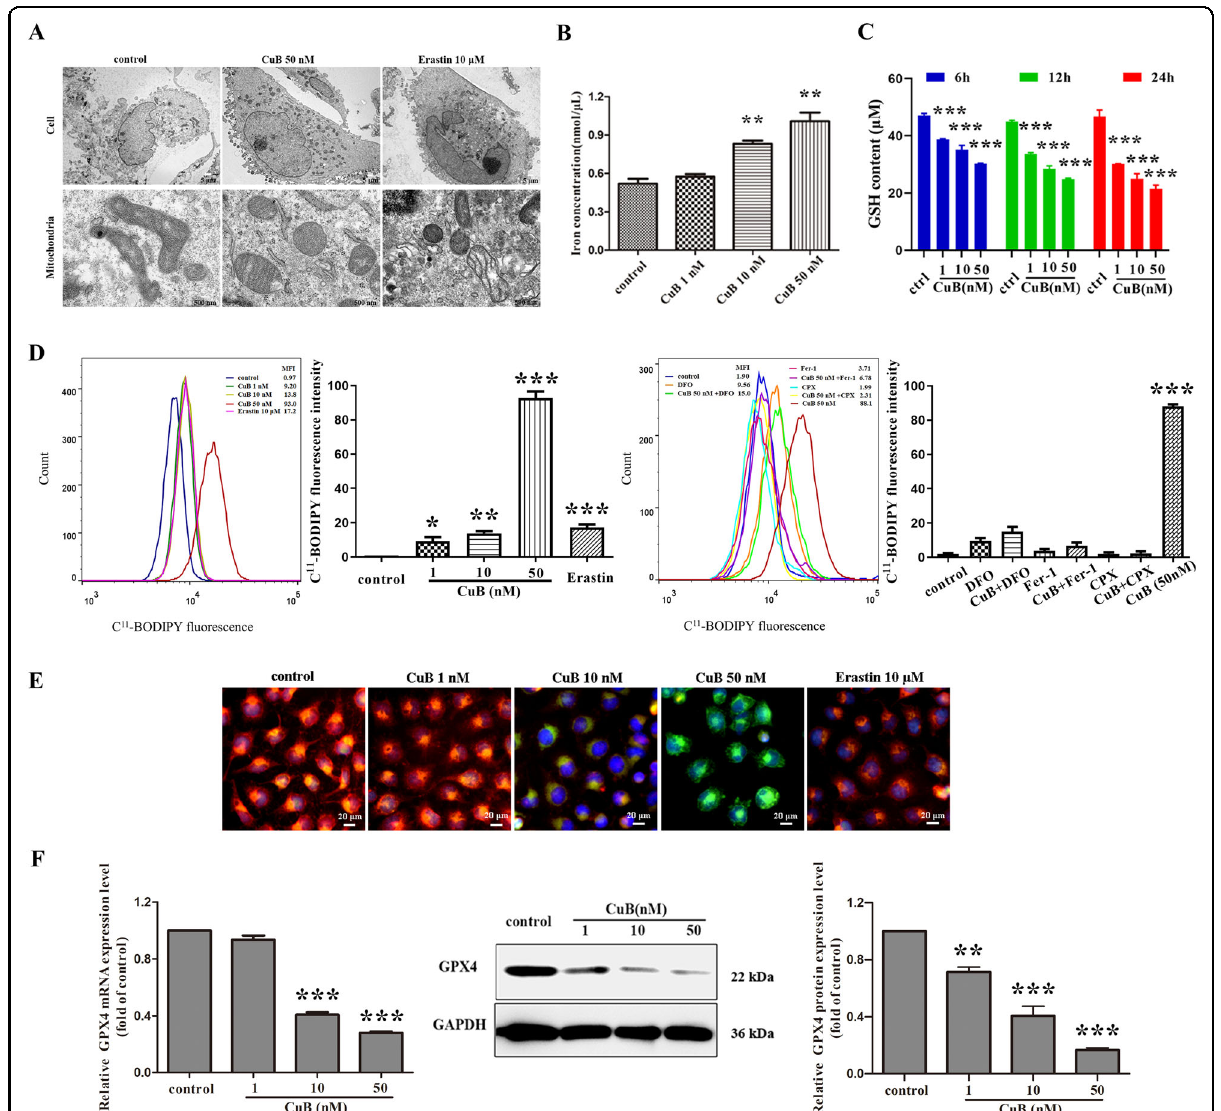
Fig. 4 CuB induced ferroptosis. A Representative cell and mitochondrial ultrastructural images of CNE1 cells treated with or without CuB (50 nM) or erastin (10 μΜ ) for 24 h. The cells were fi xed and detected by TEM (HT7700, Hitachi, Ibaraki, Japan). Scale bars: cell, 5 μ m; mitochondria, 500 nm. B Intracellular iron content in CNE1 cells exposed to CuB (1, 10, and 50 nM) for 24 h was determined with an iron assay kit (Sigma, USA). ** p < 0.01 vs . the control group by t -test using GraphPad Prism 5.0. C Intracellular GSH content in CNE1 cells exposed to CuB (1,10 and 50 nM) for 6 h, 12 h, or 24 h was determined with a GSH assay kit (Beyotime, Jiangsu, China). *** p < 0.001 vs . the control group by t -test using GraphPad Prism 5.0. D The lipid peroxidation generation in CNE1 cells exposed to CuB (1, 10 and 50 nM) with or without Nec1(50 μ M), ZVAD(50 μ M), Fer-1(5 μ M), CPX (5 μ M), or DFO (100 μ M) for 24 h. Then harvested cells were stained with C 11 -BODIPY581/591 and analysed by fl ow cytometer (Navios, Beckman Coulter). A minimum of 10,000 cells were harvested for analysis. [MFI = mean fl uorescence intensity]. * p < 0.05, ** p < 0.01, and *** p < 0.001 vs . control group by t -test using GraphPad Prism 5.0. E The fl uorescent images of lipid peroxidation in CNE1 cells using C 11 -BODIPY-581/591 probe after incubation with CuB (1, 10, and 50 nM) or erastin (10 μ M) for 24 h. Scale bar: 20 μ m. ( F ) The mRNA level of GPX4 quanti fi ed by qRT-PCR and western blot analysis of GPX4 in CNE1 cells with or without CuB (1, 10, and 50 nM) for 24 h. Quantitative analysis was performed by Image J (NIH, MD, USA). *** p < 0.001 vs . control group by t -test using GraphPad Prism 5.0. Data were presented as the mean ± SEM of three independent